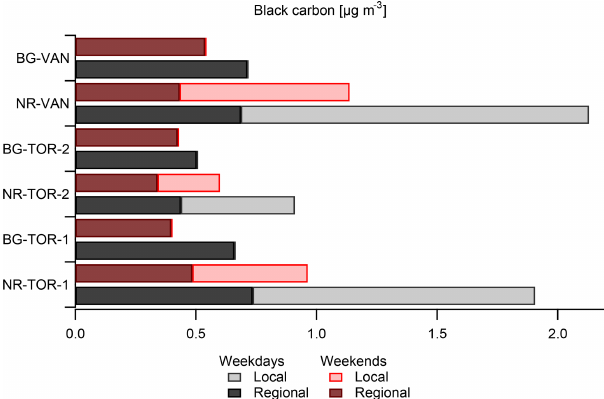
wind direction analysis in the previous section, these asso-